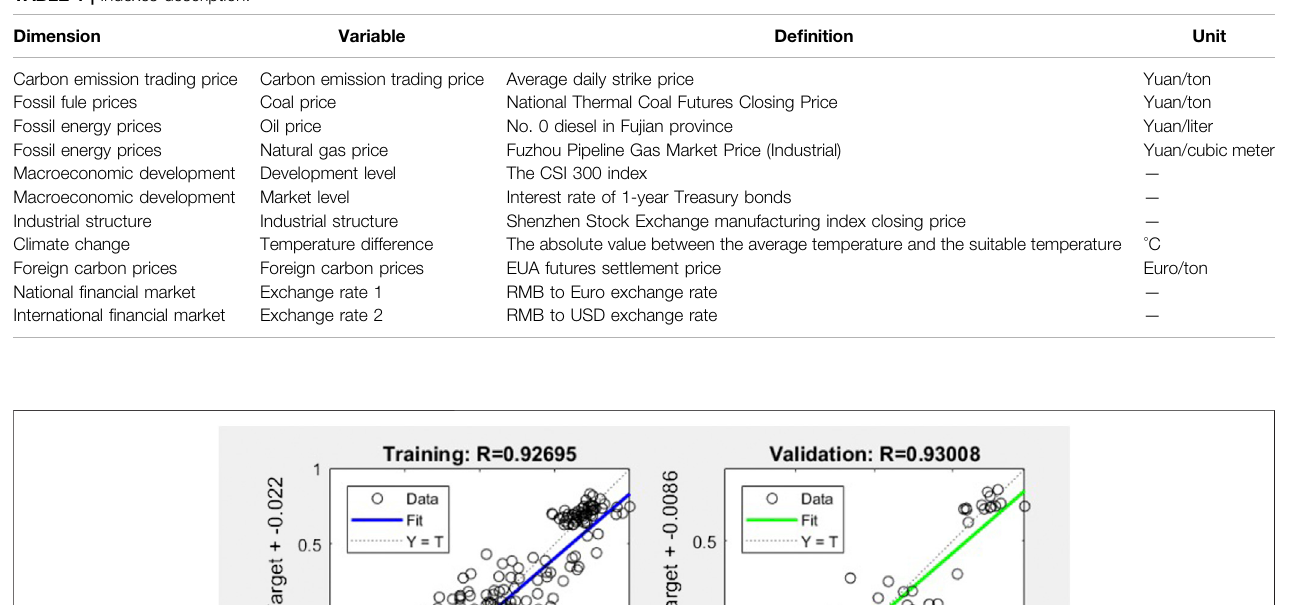
TABLE 1 | Indexes description.